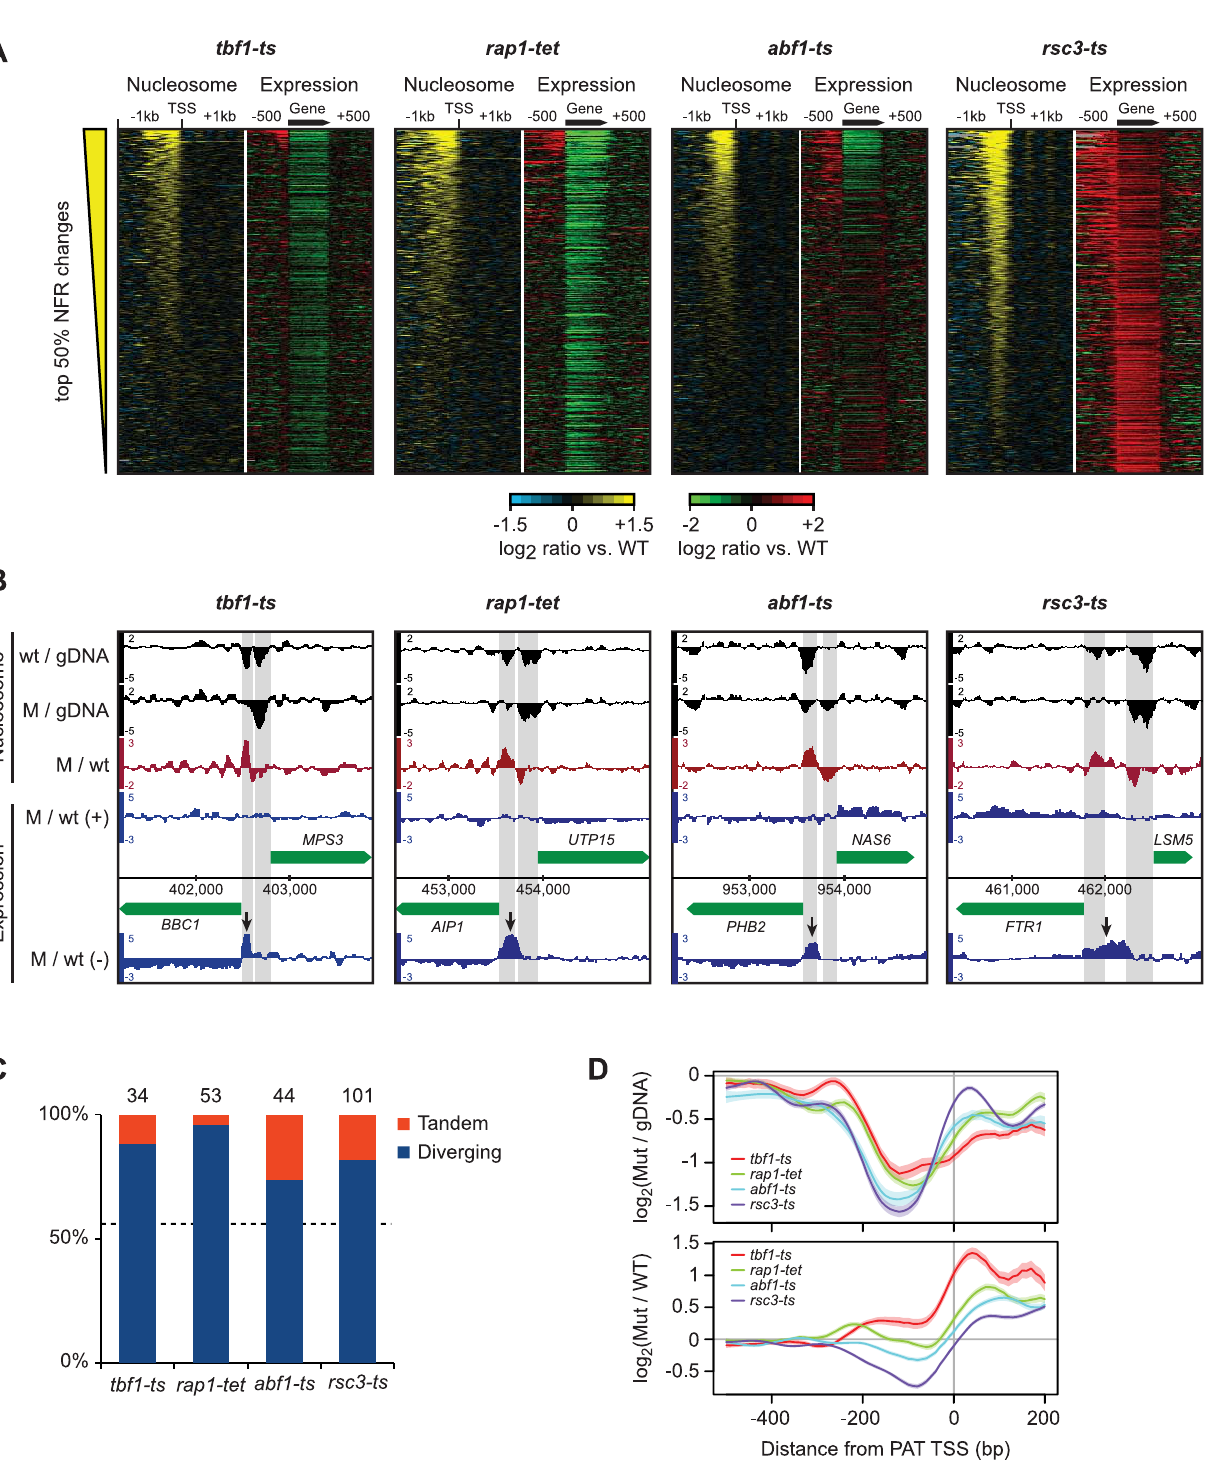
Figure 6. Disruption of nucleosome-excluding general transcription factors results in cryptic promoter transcripts. A) Correlation between changes in promoter nucleosome occupancy (left panels, yellow/blue) and transcription changes across the gene body and 1 kb intergenic flanking regions (right panels, red/green). In each panel, genes are ranked according to the average change in NDR nucleosome occupancy. NDRs were defined as the 200 bp region directly upstream of curated transcription start sites. B) Representative examples of promoter transcripts in each TF mutant (arrows). Positions of NDRs are highlighted in grey. C) Fraction of diverging and tandem genes among promoters that show significant changes in nucleosome occupancy and expression of cryptic transcripts. The number of promoter regions considered is indicated above each bar. D) Top: nucleosome occupancy relative to transcript starts for promoter transcripts in the tbf1-ts , rap1-tet , abf1-ts and rsc3-ts mutants. Bottom: changes in nucleosome occupancy compared to wild-type strains.